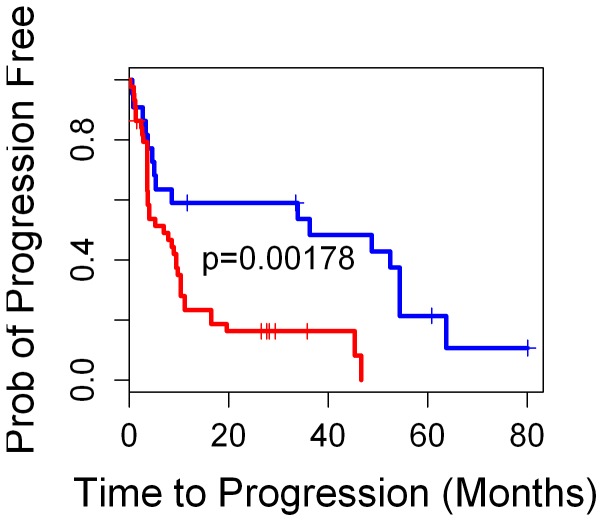
Kaplan-Meier analysis of 66 test samples based on the prediction made by the 15-gene prognostic classifier.